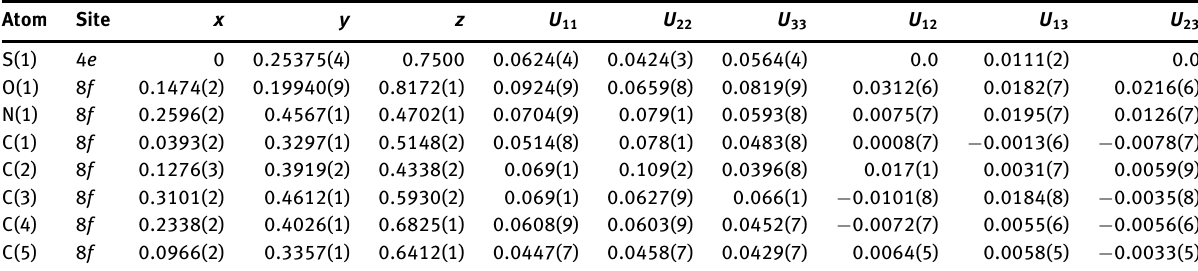
Table 3: Fractional coordinates and atomic displacement parameters (Å 2